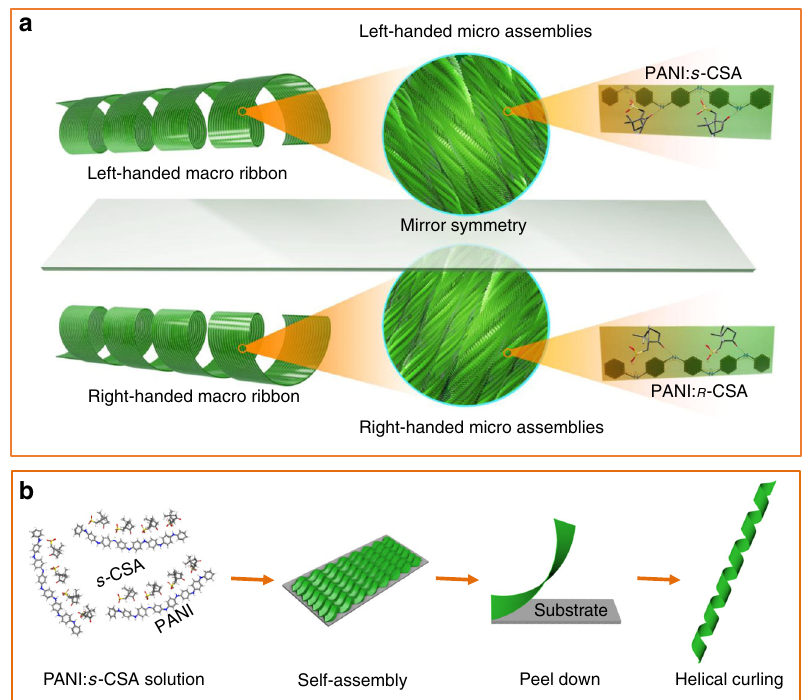
Fig. 1 Illustration for the structure and preparation of the macroscopic assemblies. a Hierarchical components of the macroribbon. The mirror symmetrical left- and right-handed macroribbons (left) consisted of aligned left-handed and right-handed nano-assemblies and micro-assemblies (middle) and single- handed PANI polymer doped by s -CSA and ʀ -CSA (right), respectively. b In-situ doping PANI with enantiomeric CSA-dopant by polymerization of aniline monomer in organic solvent; self-assembly of PANI molecules and its microscopic fi brous assemblies on the uniaxial stretched PP substrate; peel down the PANI macrostripe from the PP substrate in THF solvent; curl the macrostripe into helical ribbon with adding